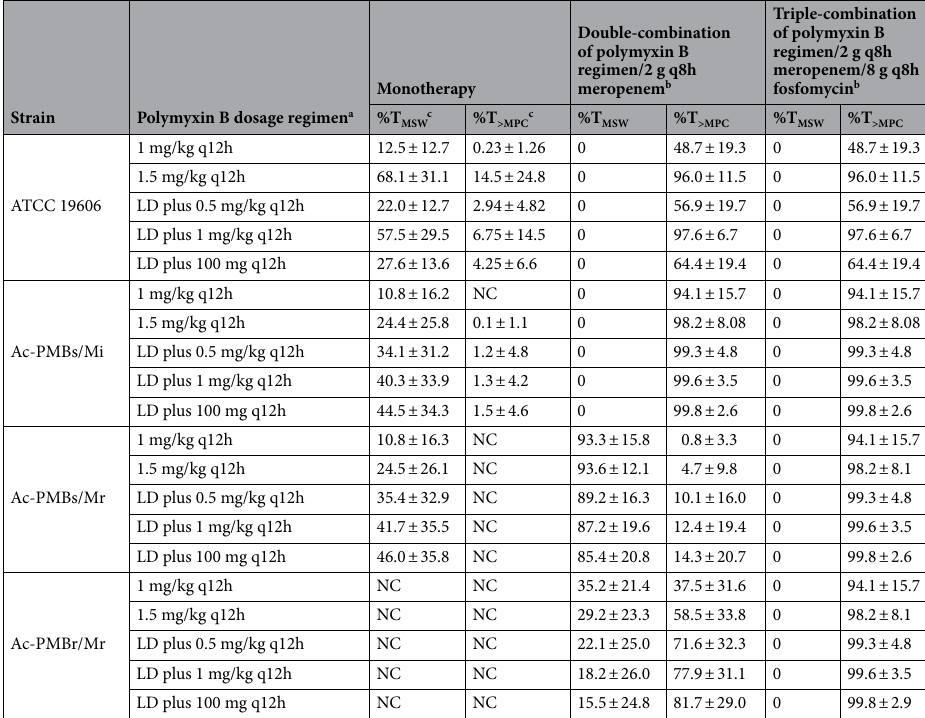
Table 2. MSW-derived PD indices of polymyxin B alone and in combination against A. baumannii strains. MSW mutant selection window, MPC mutant prevention concentration, LD loading dose of 3.0 mg/kg, NC not computable because polymyxin B MIC is higher than maximum. Values reported as mean ± SD. a All regimens were 1-h infusions. b Meropenem and fosfomycin regimens were administered as 3-h prolonged infusions. c T MSW or T >MPC was calculated as the percentage of the first 24